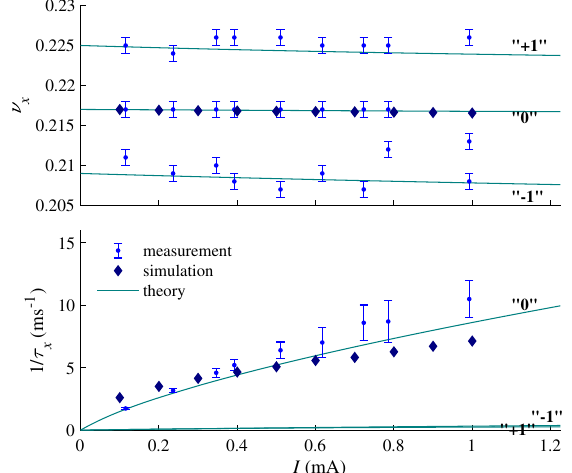
¼ 2 . 1 ; feedback on. y